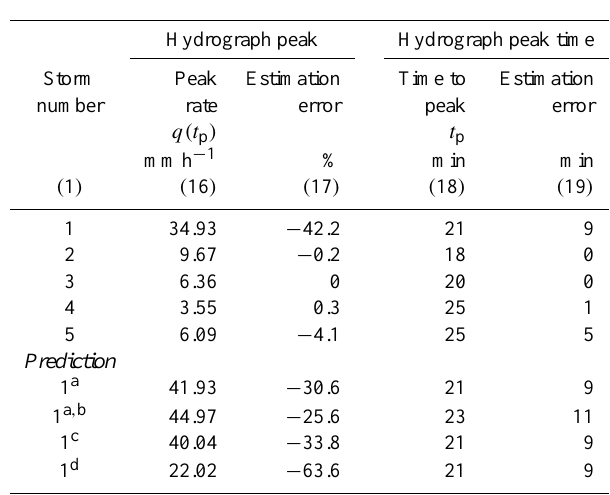
Table 2c. Unit hydrograph data for the Edwardsville catchment. Regeneration of unit peak characteristics by the inverse Bakhmeteff function method of convolution.